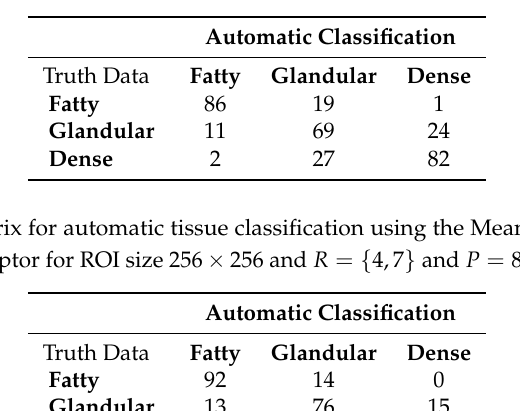
Table 4. Confusion matrix for automatic tissue classification using the Uniform-Elliptical Local Binary Pattern (uniform-ELBP) descriptor for ROI size 256 × 256 and R = { 4,7 } and P = 8.